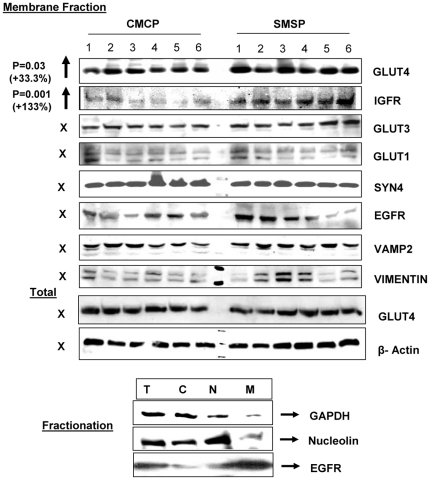
Cellular fractionation of possible target proteins based on microRNA bioinformatics analysis and the insulin-signaling proteins for glucose transport: Membrane fraction.The biochemical fractionations of the membrane proteins were made using Chemicon/Millipore's compartmental sub-cellular analysis technology. Cytosolic, membrane, nuclear and cytoskeleton fractions have been made from SKM tissues from both control (CMCP) and experimental (SMSP) male animals. SDS-PAGE followed by Western Blot analysis was made using 50 µg of total protein from every fractions based on Bradford assay. The localization of GLUT4 and IGFR in IPGR male SKM is significantly increased in membrane fractions when the total GLUT4 protein level remains unaltered in male SKM. GLUT1, 3 and 4 are Slc2 group of glucose transport proteins, IGFR is Insulin Growth Factor Receptor protein, EGFR is used as internal control for membrane localized protein. Vamp2 and Vimentin are two essential regulatory protein markers for insulin signaling and cell differentiation. β-Actin was used as internal control for total protein. The bottom panel represents the verification data for the cell fractionation. GAPDH, Nucleolin and EGFR were used for cytosolic (C), nuclear (N) and membrane (M) localized proteins. T represents total protein.